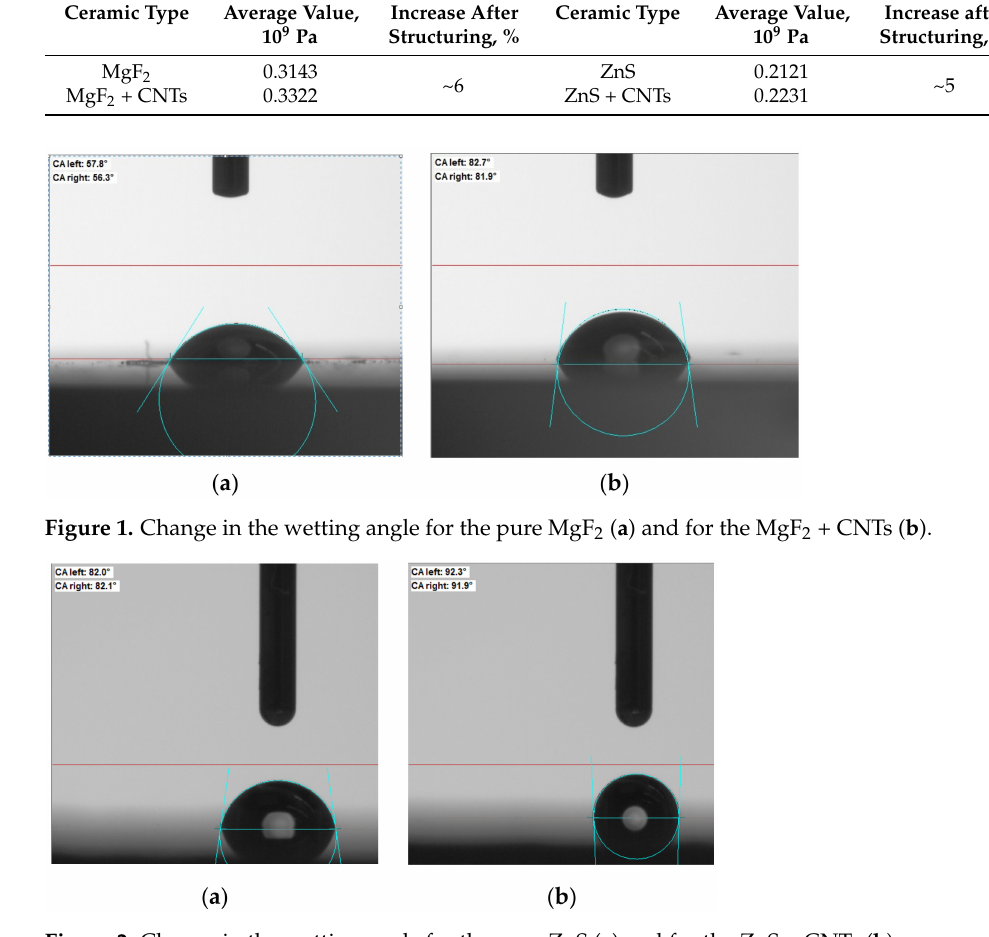
Figure 2. Change in the wetting angle for the pure ZnS ( a ) and for the ZnS + CNTs ( b